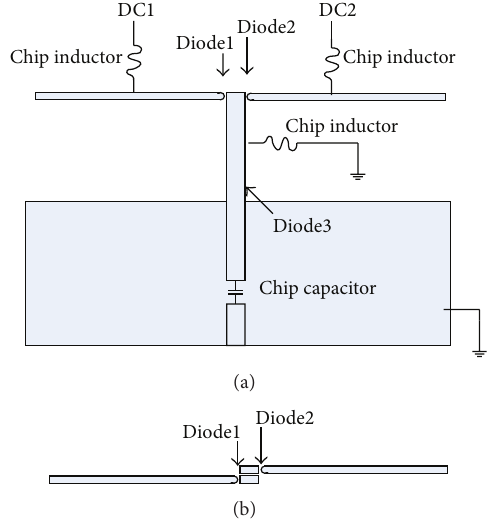
Figure 3: Radiation pattern reconfigurable antenna. (a) Side view. (b) Top view (redrawn